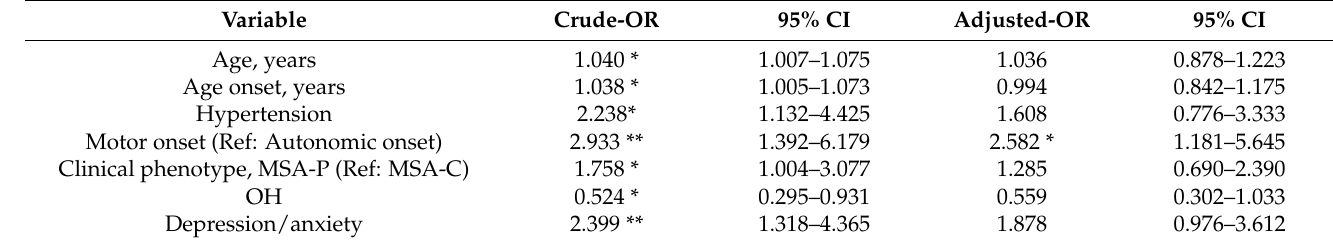
Table 3. Logistic regression analyses for the factors associated with MSA-MCI.